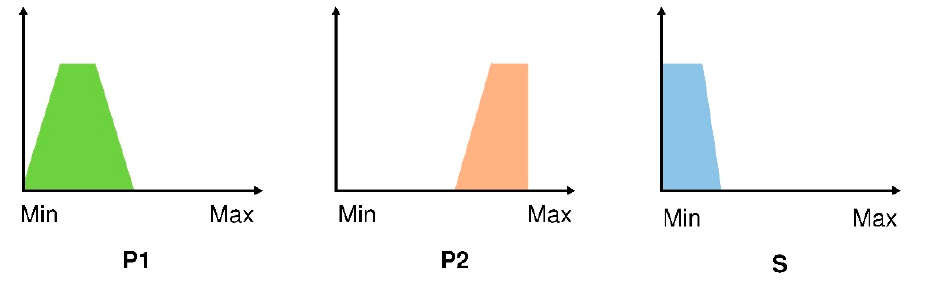
Figure 1. Example of fuzzy rule (antecedents: P1, P2 and consequent: S).